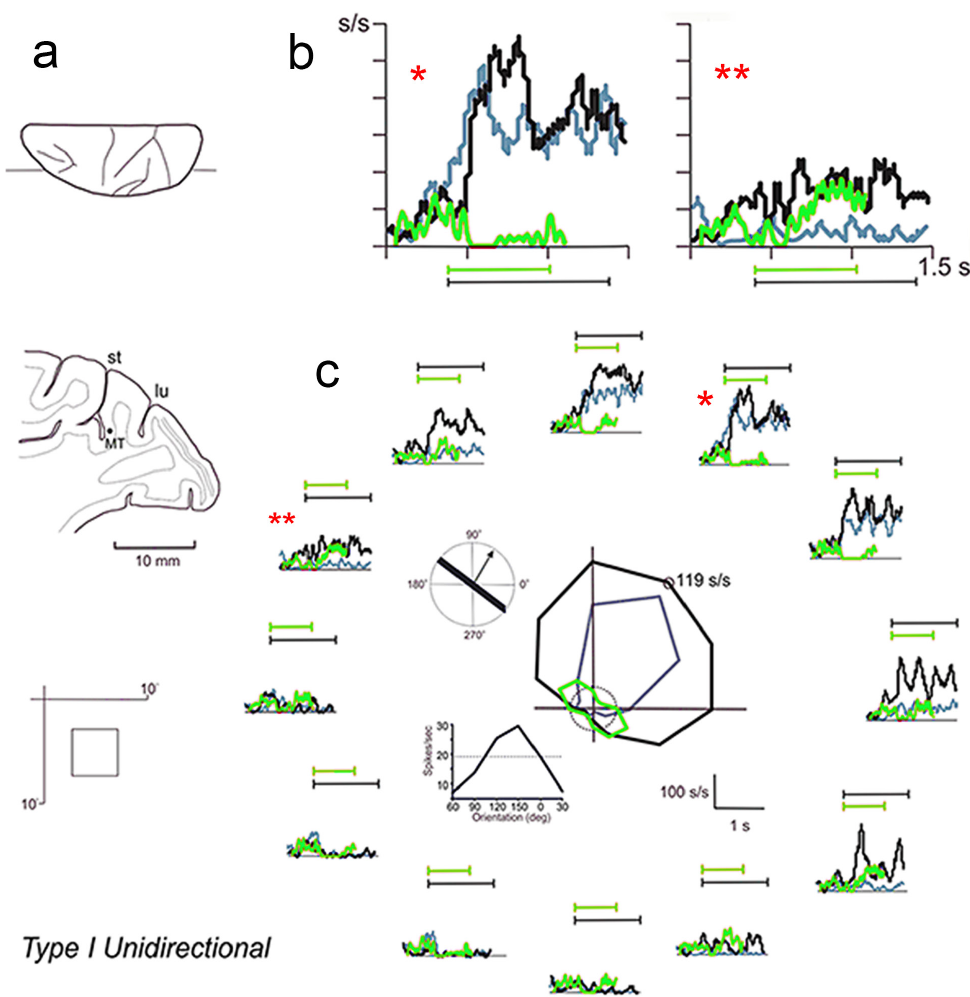
Figure 2. Example of an MT site showing Type I unidirectional activity. (a) top : Dorsal view of the brain indicating the sagittal plane illustrated in the middle panel. The black dot indicates the location of the recording site. Bottom : Receptive field of the recorded site (located within 5°-10° of the center of gaze). Panels b and c show the corresponding neuronal responses to moving dots (black traces), moving gratings (gray traces) and static gratings (green traces). The black and green line segments below or above the activity traces denote the corresponding visual stimulation epochs for the moving (dots and gratings) and static (grating) stimuli, respectively. Panel c illustrates the averaged (10 trials) neuronal responses for the 12 directions of motion tested. The polargram in the middle represents the mean response rate for the 12 directions averaged over the stimulation epoch. The data points used to construct the polarplot for orientation (green trace) is based on 6 orientations. These 6 data points were mirrored in order to generated a 12-point polarplot, facilitating the comparison between orientation and direction selectivity. The circular dashed line at the center of the polar plot depicts the averaged spontaneous activity. Note that the response to moving gratings were characteristically weaker than those to moving dots (maximum average response of 119 spikes per second or s/s). However, the general selectivity profile was similar for both moving stimuli (optimal response at 60°). Static gratings elicited optimal responses at an orientation orthogonal (i.e., 150°) to the preferred axis of movement (compare the black/gray vs. green traces of the polargram and the two inserts to the left). Panels in B show enlarged versions of the histograms for the preferred direction of motion (60°, left panel) and for the preferred orientation axis (150°, right panel). Asterisks indicated the corresponding conditions in (b) and